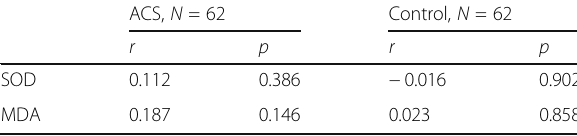
Table 3 Correlation of CD147 gene fold change with SOD